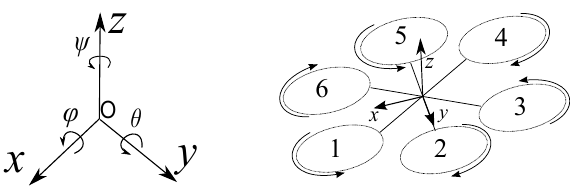
Figure 1. Structure of hexarotor and coordinate frames.